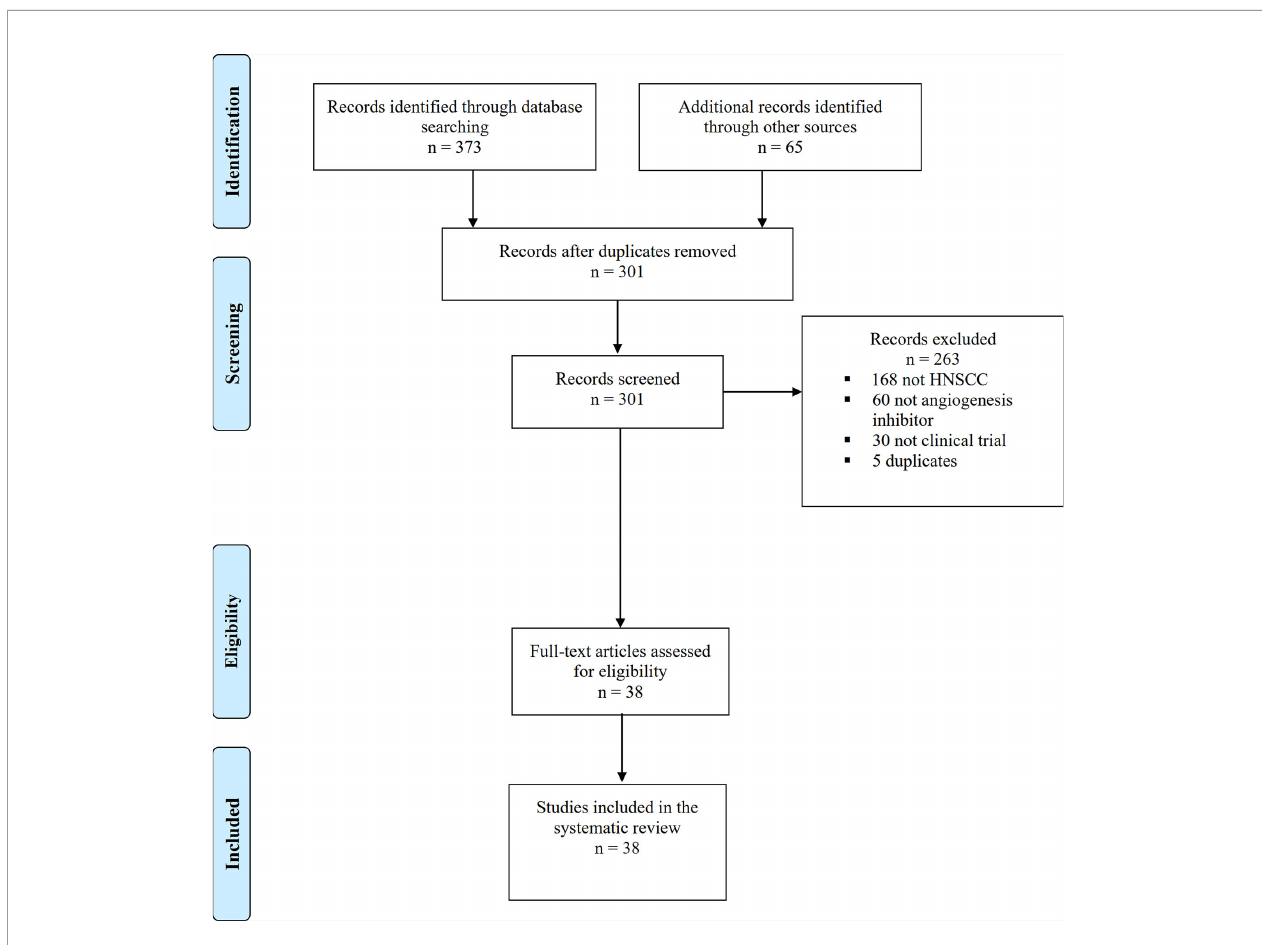
FIGURE 1 | PRISMA fl ow chart with search results and studies included and excluded in different